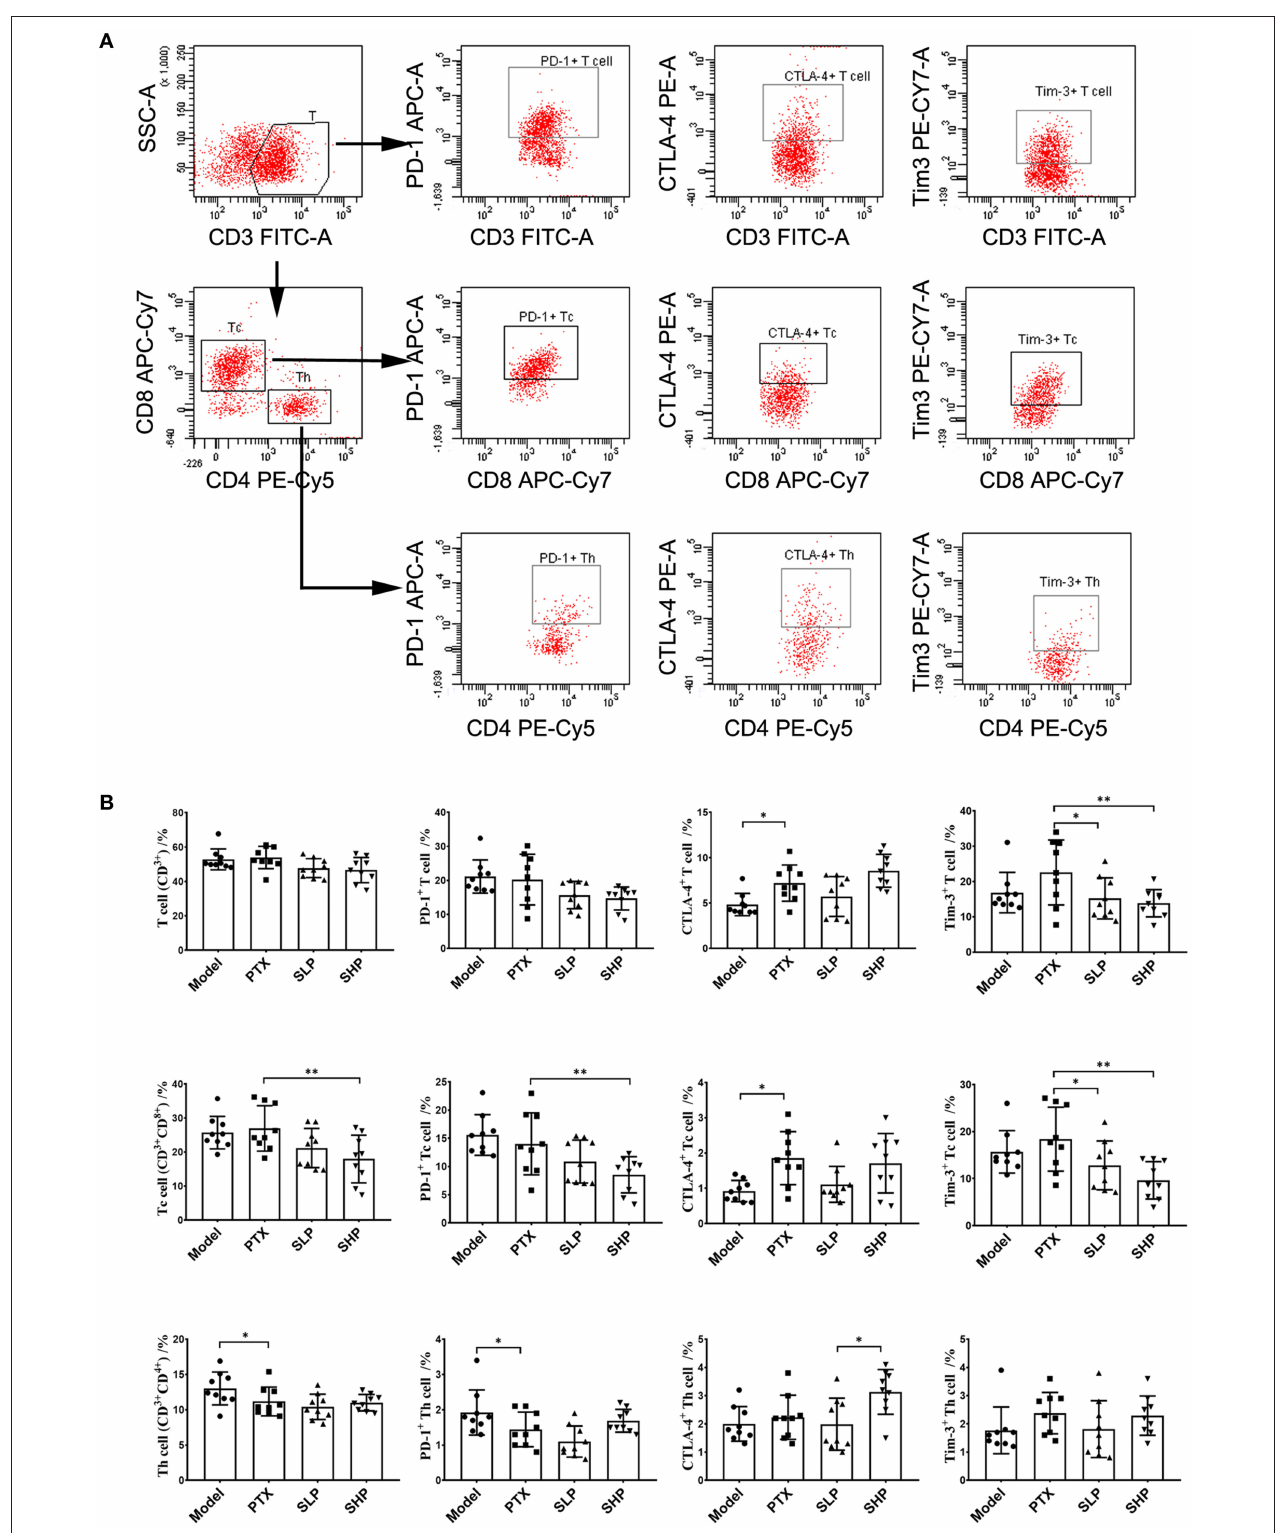
FIGURE 2 | Tumor infiltrating lymphocyte (TIL) analysis by flowcytometry. (A) Flowcytometry analysis scheme presented by dotplot. (B) Proprotion of TIL subsets (first line panel) and the immune checkpoint-positive TILs (second to fourth line panels) comparison. Values were represented the means ± SD ( n = 9). * p < 0.05 and ** p <